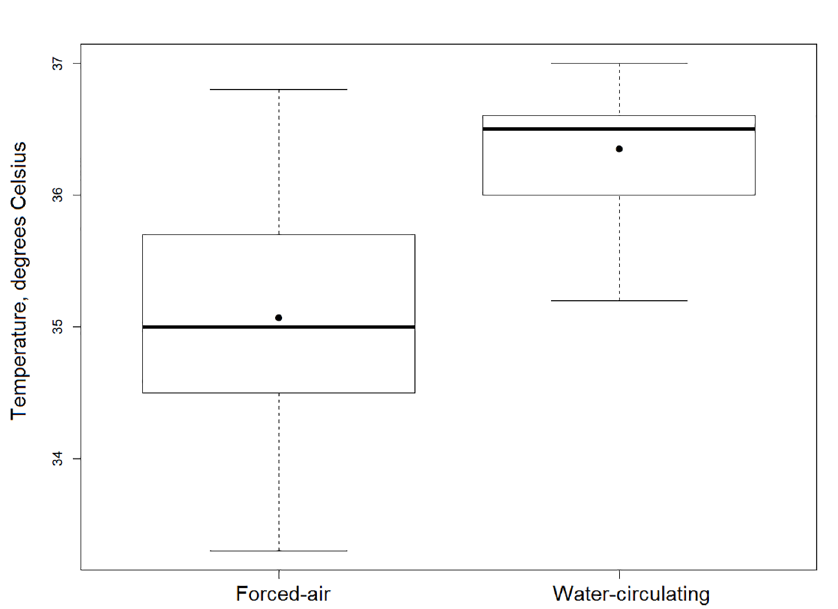
Fig 2. Temperature on arrival to the CTU. Mean temperatures ± SD for patients warmed with the forced-air and water-circulating deviceswere 36.4 ± 0.4 and 35.1 ± 0.8 degreesCelsius, respectively(p < 0.001). Overall, 97% of patients warmed with the water-circulating device versus 13% of those warmed with the forced-air device were above36.0 degreesCelsius upon arrival to the CTU (p < 0.001).